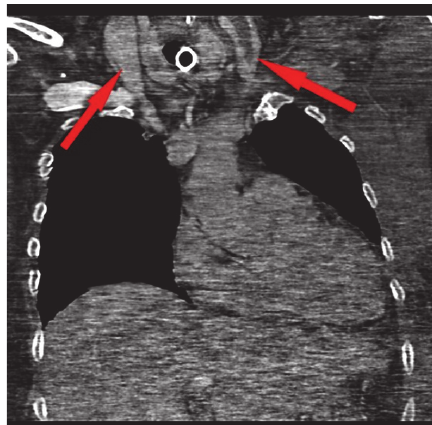
Figure 5: MR imaging of the cranium with multiple small rotund lesions in the sense of septic emboli (red